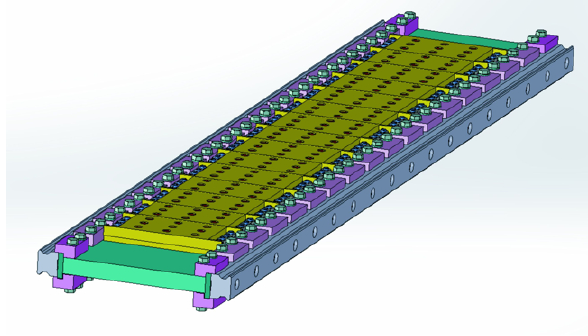
Figure 9: Alternative arrangement of the recirculating ball bearings for the translation of the